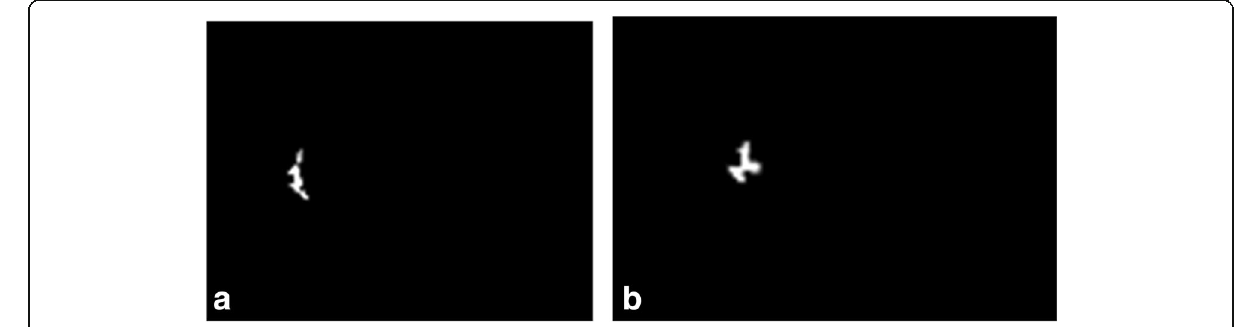
Fig. 6 Example of nipple masks not perfectly segmented by the algorithm. a Example 1. b Example